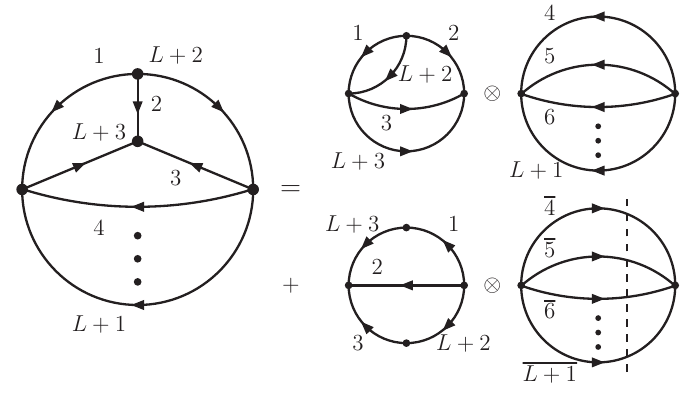
Figure 8 . Dual expansion of a N 2 MLT ( L ) diagram.